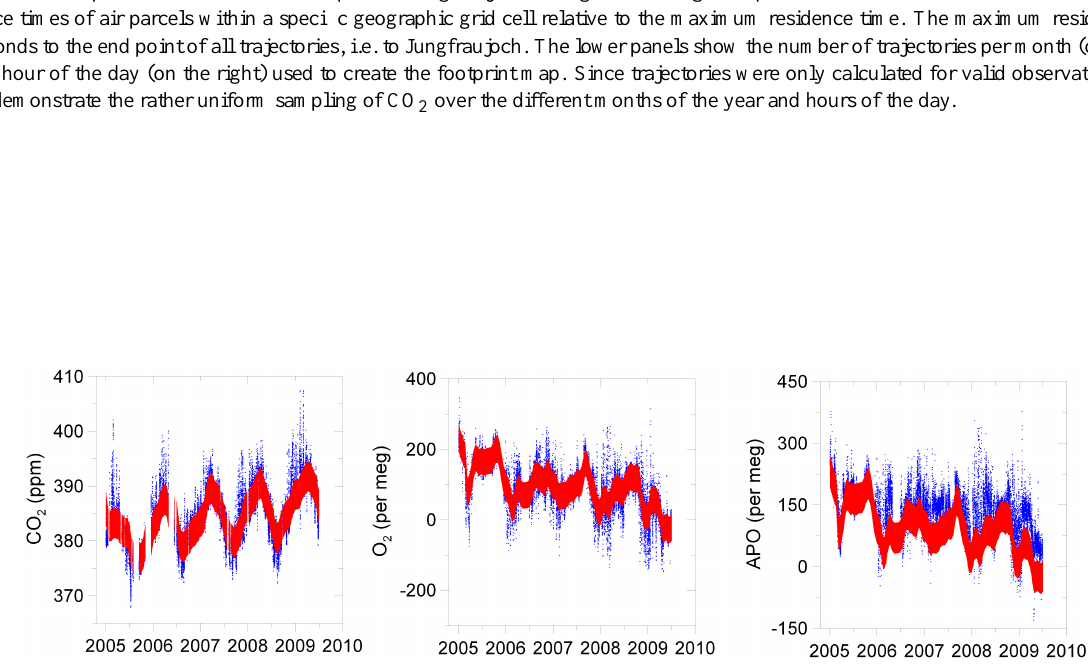
Fig. 3. CO 2 (left), O 2 (centre) and APO (right) hourly means (in blue) with the iteratively calculated background range (in red). After background subtraction, the remaining data is considered and included in the Lagrangian transport